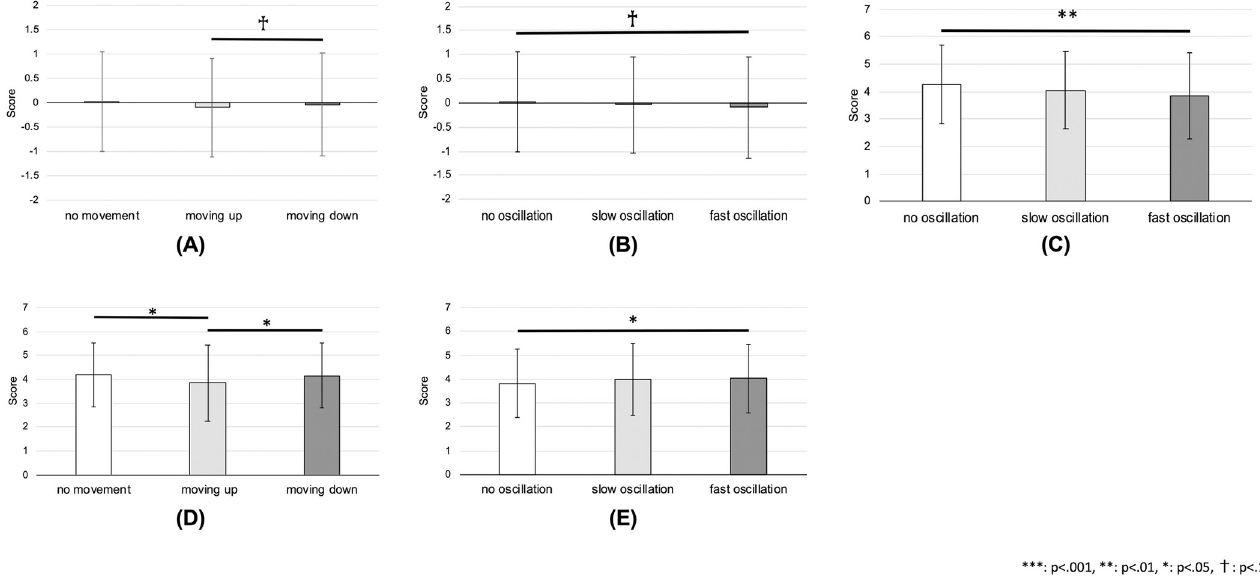
Fig 7. Results for sadness and relief in short-term expressions. Score of the expressivity and clarity by different vertical transitions or oscillations of the robot in the case of the short-term representation of sadness and relief: (A) expressivity of sadness by vertical transition and (B) by vertical oscillation, (C) clarity of sadness by vertical oscillation when the robot had a moving-up behavior and (D) by vertical transition when the robot had a fast oscillation, (E) clarity of relief by vertical transition. Note that for the expressivity, the improvement of the score is shown as explained in the paper.